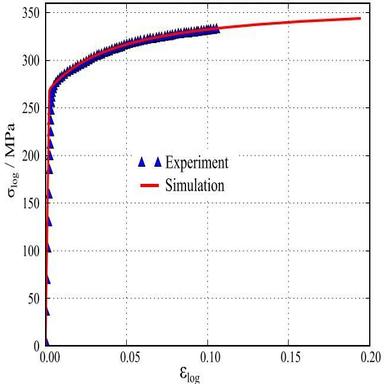
Experimentally obtained and fitted stress-strain curves of cold-rolled AA3104. The experimental result is taken from the work of Wu et al. . Figure adopted from with permission from Elsevier.